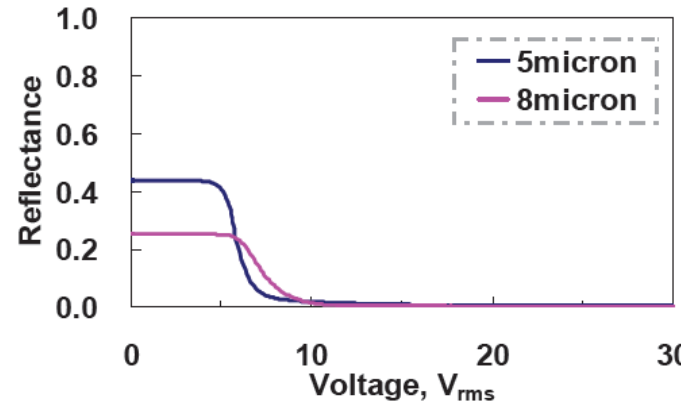
Figure 10. Voltage-dependent reflectance of different cell